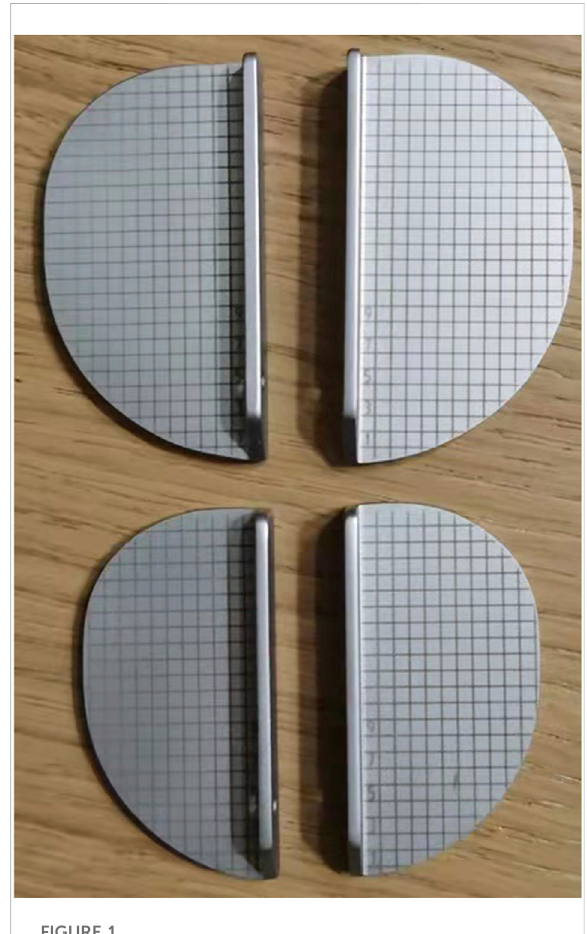
FIGURE 1 Gridding mold of the tibial component; the interval was 2